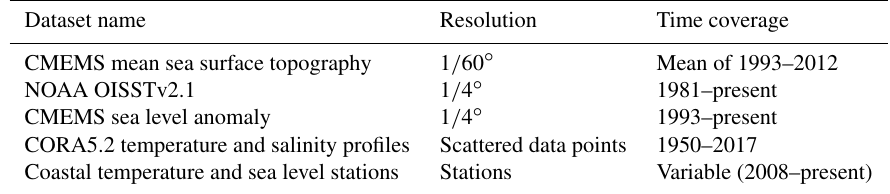
Table 1. Observational datasets used for the Moana Ocean Hindcast evaluation.